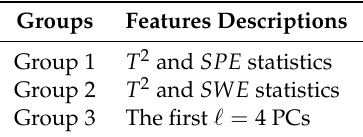
Table 2. Selected features for fault classification.